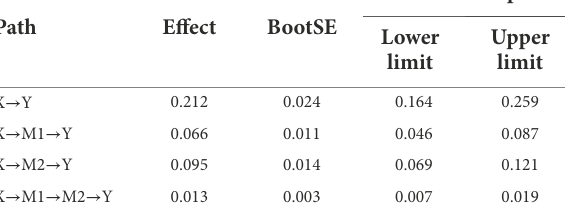
TABLE 3 Bias-corrected percentile bootstrap testing of each